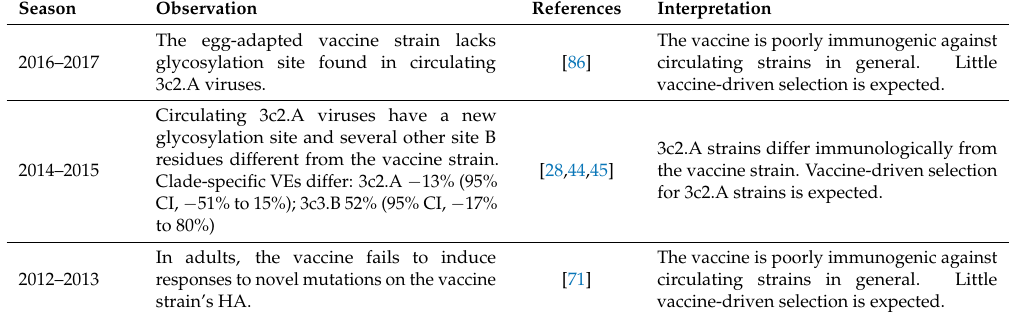
Table A5. Evidence for potential vaccine-driven selection among H3N2 strains.